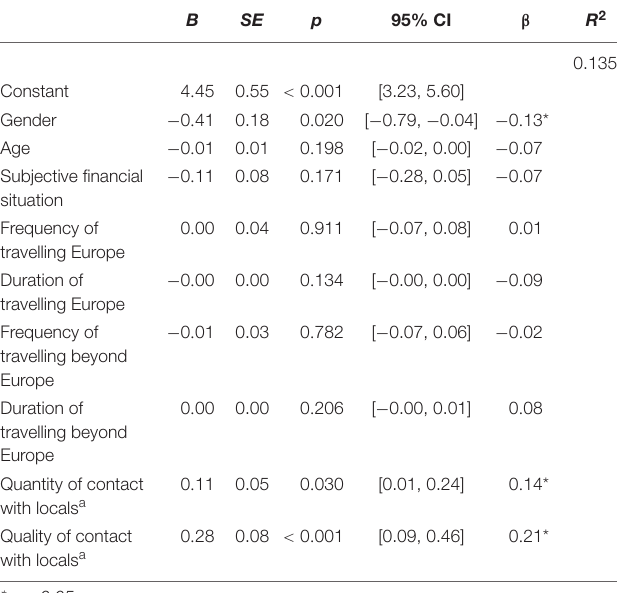
TABLE 2 | Results of regressing global identity (mean score) on travel experiences.